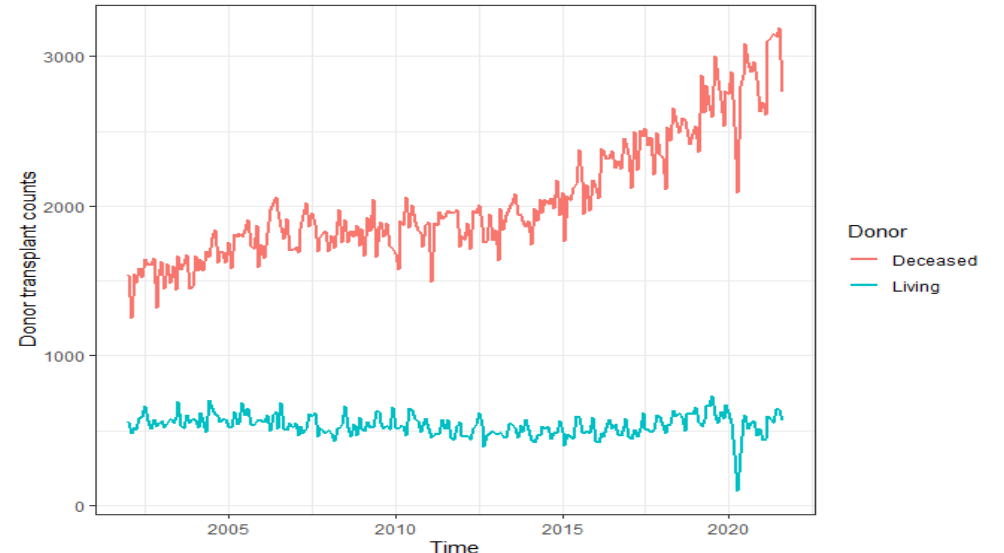
Figure 1. Donor transplant counts in the US by donor type, based on OPTN data as of November 2021.